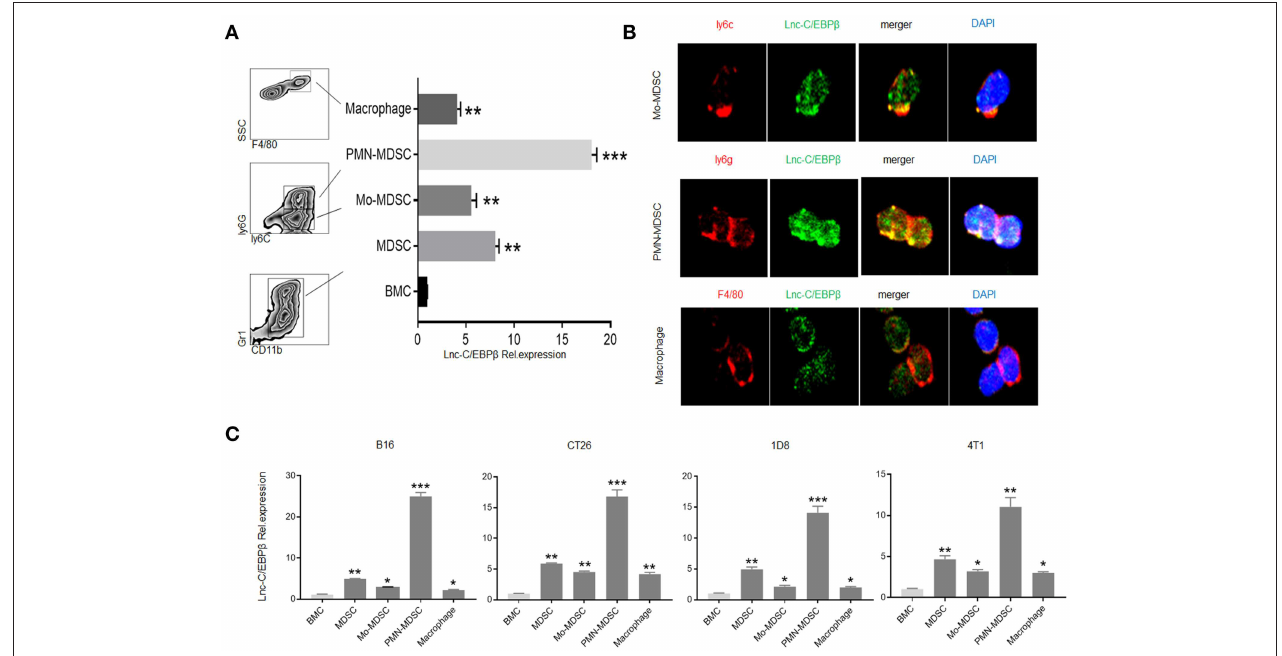
FIGURE 1 | Different levels of lnc-C/EBP β in PMN-MDSCs, Mo-MDSCs, and macrophages. (A) QRT-PCR of lnc-C/EBP β in the MDSC subsets isolated from GM-CSF plus IL6 mediated MDSCs. (B) Fluorescence in situ hybridization of lnc-C/EBP β in mouse MDSC subsets. (C) QRT-PCR of mouse lnc-C/EBP β in MDSC subsets isolated from the tumor of mice bearing melanoma B16, colon cancer CT26, ovarian cancer 1D8, and breast cancer 4T1. Data in (A,C) are a representative of three independent measurements. Two-tailed, paired T -test was used in (A,C) . * p < 0.05; ** p < 0.05; *** p < 0.001.